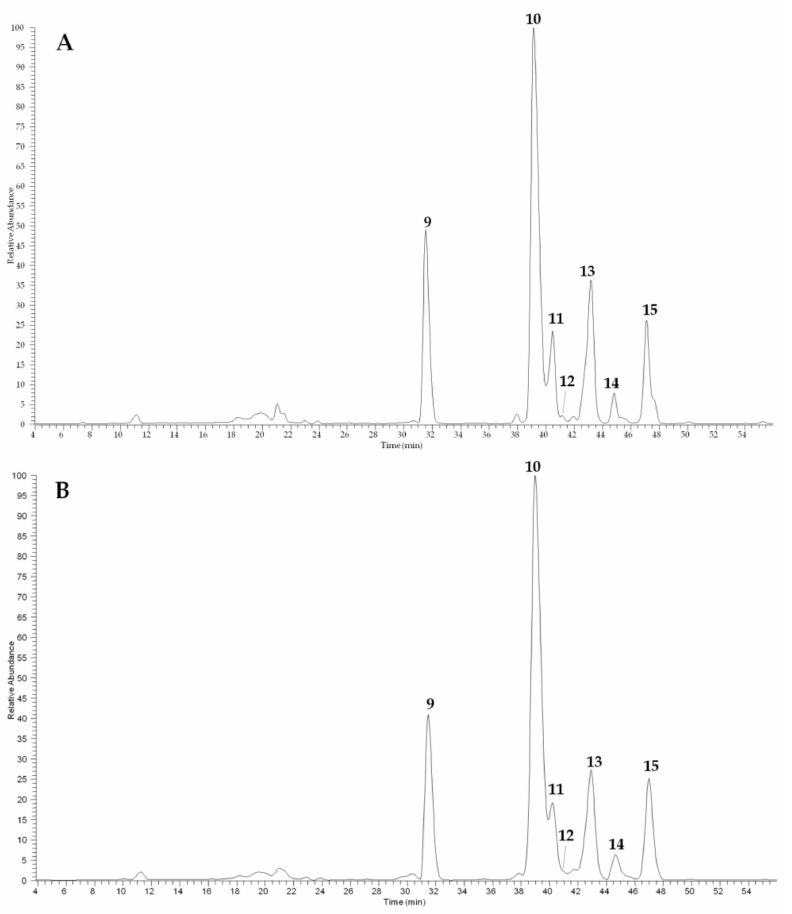
Figure 5. HPLC–ESI–MS profiles (registered in negative ion mode) of camelina meal extracts culti- vated in Pisa ( A ) and Bologna ( B ). For peak data, see Table 4. Table 4. Spectral (UV and ESI–MS/MS) and chromatographic data ( t R , retention time) of compounds 9 – 15 , detected in camelina meal extracts.